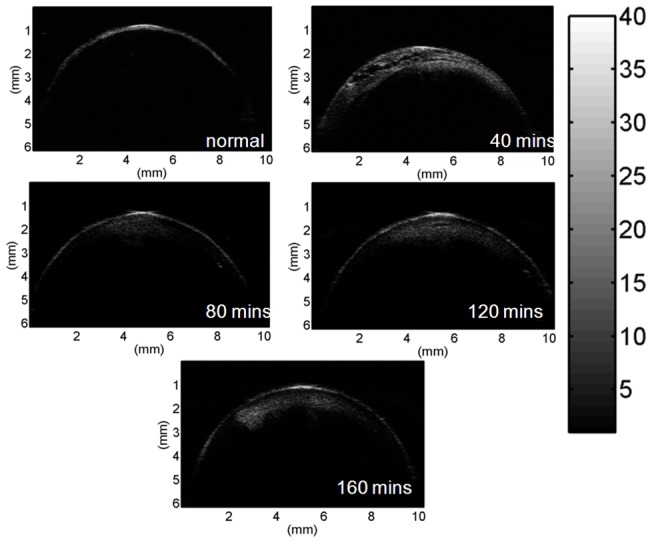
Representative B-mode images of the porcine lens at different stages of cataract formation.